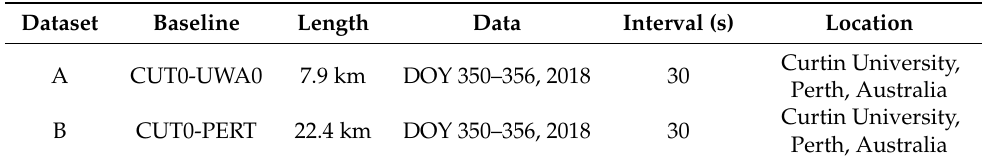
Table 4. Characteristics of the